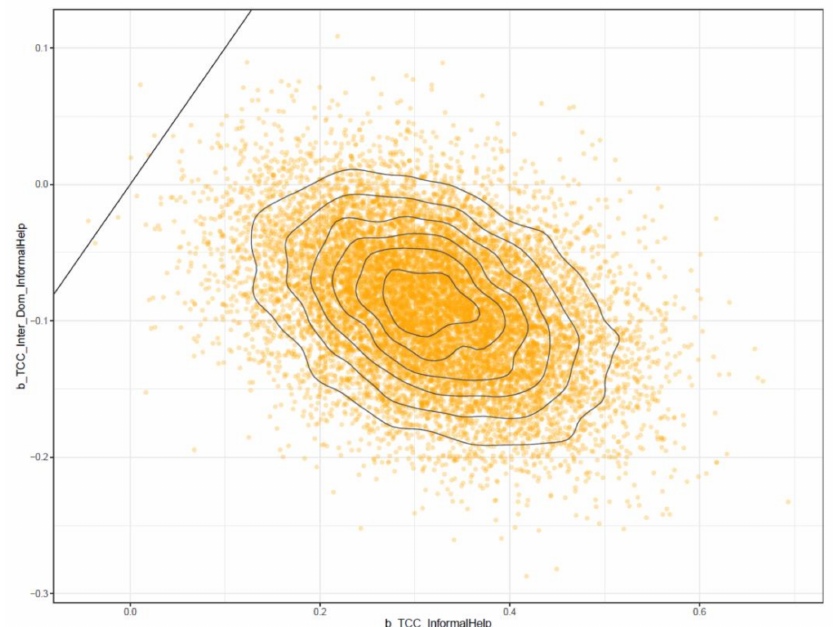
Figure 10. Pairwise distribution plot for model 2 (cid:48) s TCC and TCC*Inter_Dom .